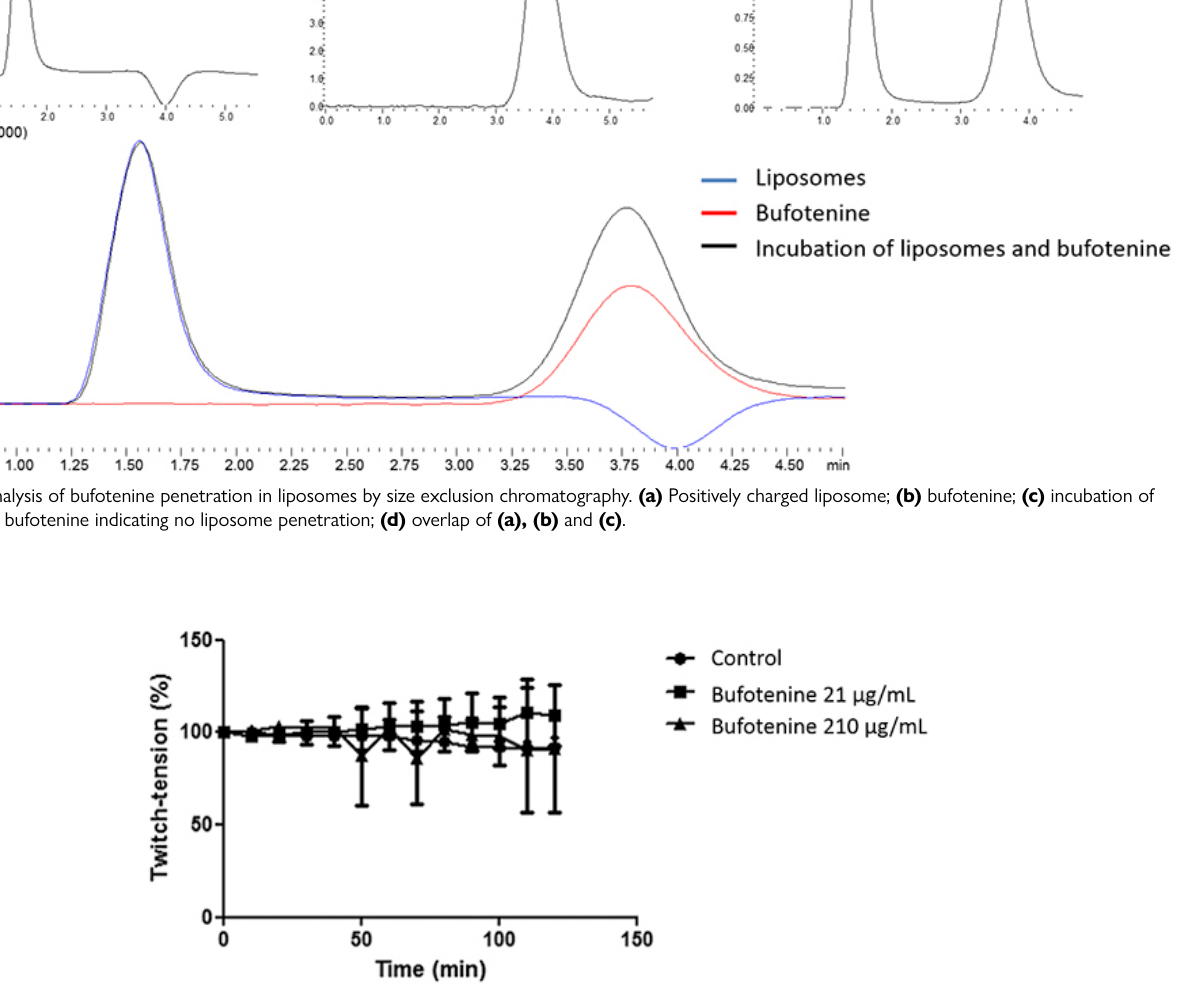
Figure 4. Representative neuromuscular response of phrenic nerve-diaphragm muscle (PND) preparation under stimulation. Bufotenine (21 and 210 μg/mL) was unable to induce neuromuscular blockade. The points represent the mean ± SEM of 7-4